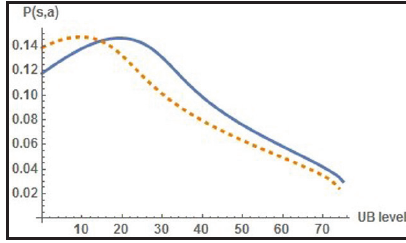
Cash Transfer Effect [BM]. This graph shows the job-finding probability P ( s , a ) for different values of b . The continuous line is generated with the functions and parameters of Table 1. The dashed line uses the same functions and parameters, the only difference being that the agent receives a transfer of 10 regardless of her employment status.